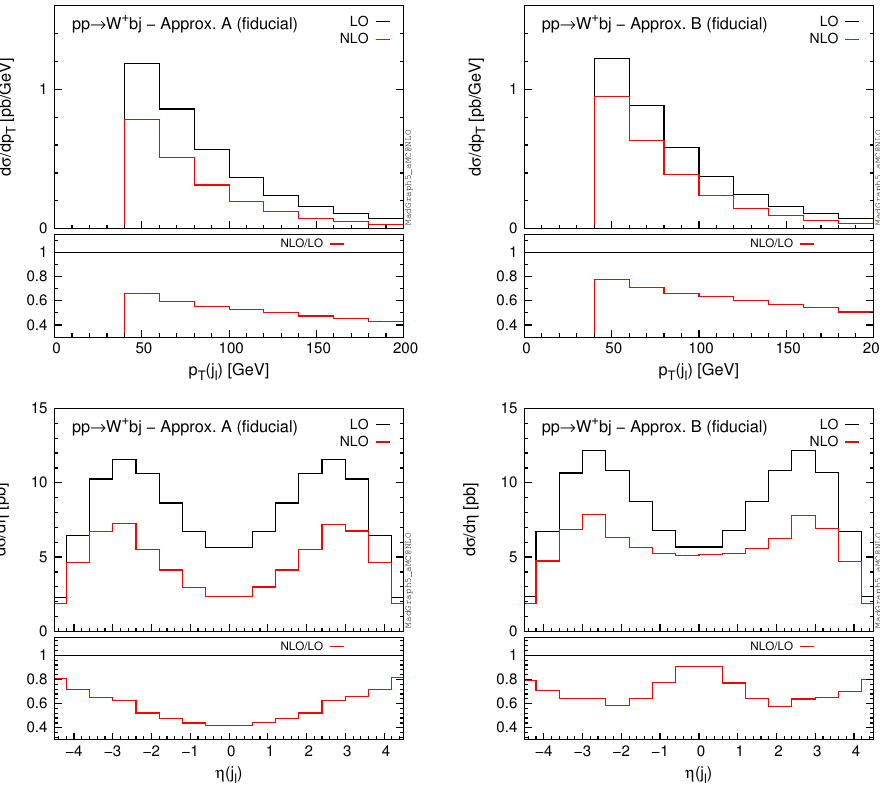
Figure 13 . Same as (cid:12)gure 12, but applying part of the (cid:12)ducial-region cuts (see text for details). used. Therefore, the behaviour of the scale uncertainties is very sensitive to the de(cid:12)nition of the (cid:12)ducial region. Moreover, in ref. [39] it was pointed out that LO, NLO and even NNLO QCD uncertainty bands do not overlap. This comes with no surprise since we have shown in this paper that QCD shower e(cid:11)ects are